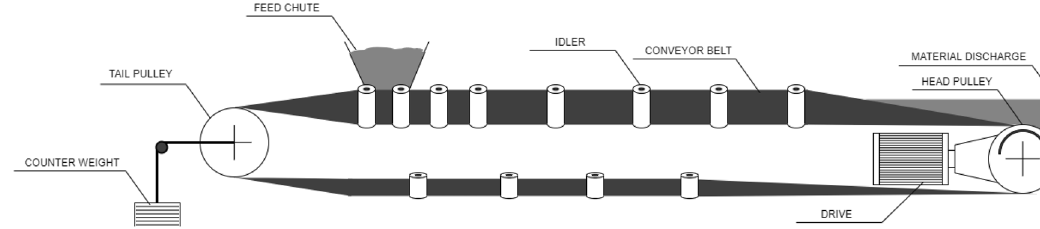
Figure 1. Diagram of the conveyor belt.